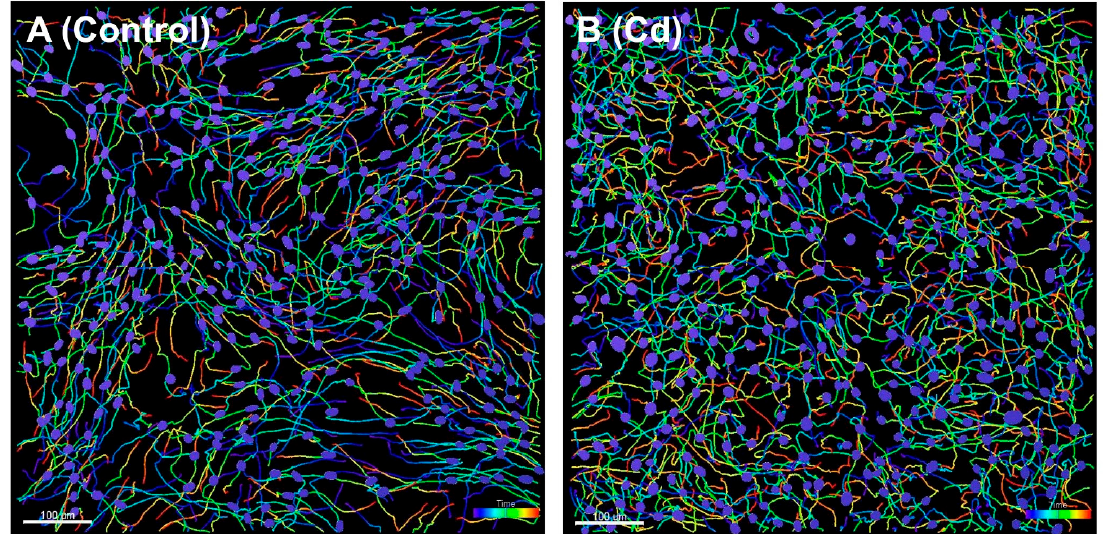
Figure 1. Full track display of nuclear surface objects to illustrate migration patterns. The images were captured at time frame number 50 (at 245 min). ( A ). Ht-UtLM6 tracks showed relatively parallel bundles in multiple regions. ( B ). CR-LM6 tracks showed relatively random and disorganized patterns. Scale bar = 100 µm.